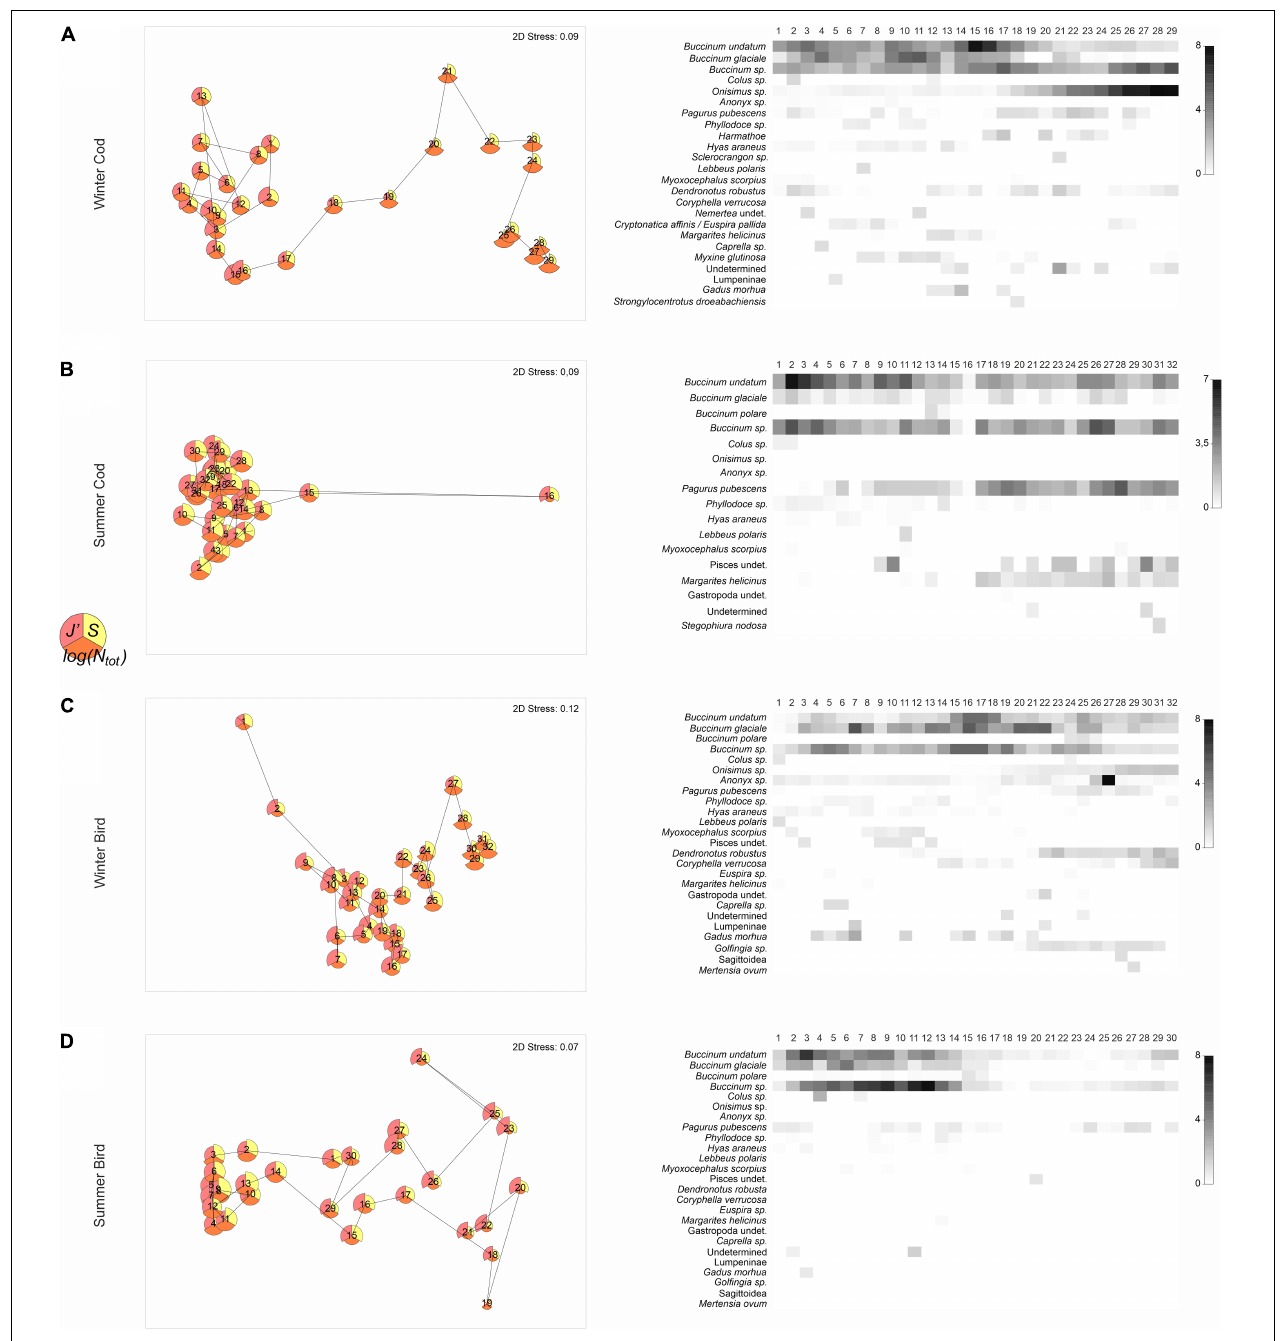
FIGURE 8 | (A–D) Non-metric MDS plots of scavenger assemblages from different bait types (cod, bird) and seasons (winter, summer) calculated on the basis of Bray–Curtis dissimilarities after a transformation using dispersion weighting of average abundances (for n = 12 photographs), with temporal trajectory connecting the points through time (numbers show the sequential ordering from 1 up to ∼ 32 for the sampling units spanning 180 min) and overlying bubbles with data for S (yellow), log(N tot ) (orange), and J (cid:48) (pink). Each plot has a corresponding shade plot of the underlying data matrix. The larger the entry in a specific cell, the darker the shade plotted, white representing the absence of that species, and full black the largest entry in the whole matrix.